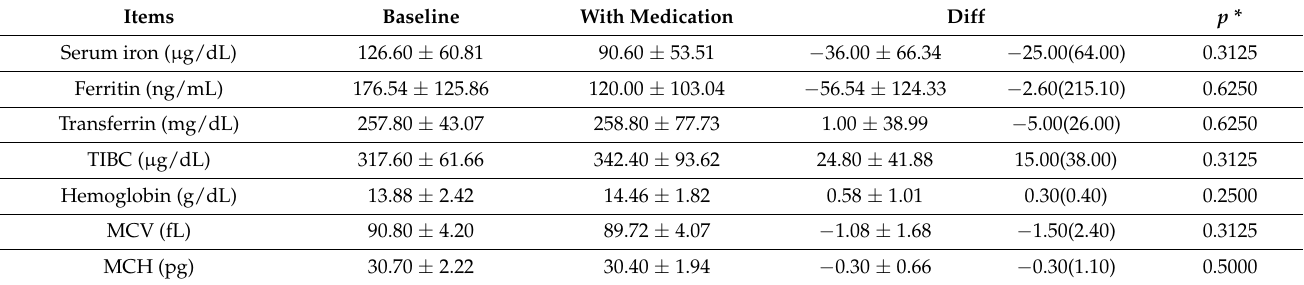
Table 3. Comparison of findings from laboratory and transcranial Doppler sonography (TCS) before and after methylphenidate treatment ( n =